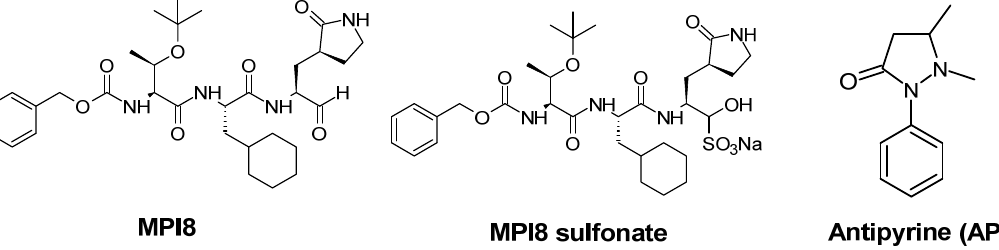
Figure 1. Chemical structures of MPI8, its prodrug MPI8 sulfonate, and antipyrine (AP, internal standard).